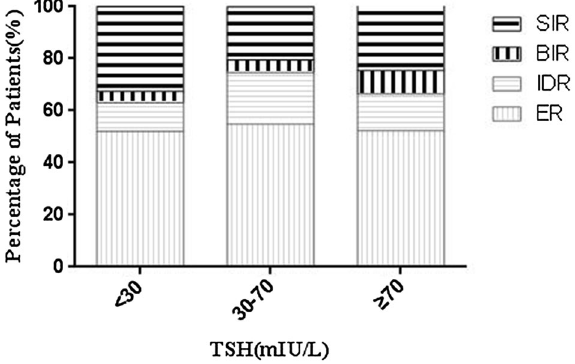
Figure 1. Pre-ablative TSH group and percentage of patients with response (ER, IDR, BIR and SIR) after RRA. The complete response (ER + IDR) was 63.04%, 74.59% and 66.41% separately each in three pre-ablative TSH groups of < 30, 30–70 and ≥ 70